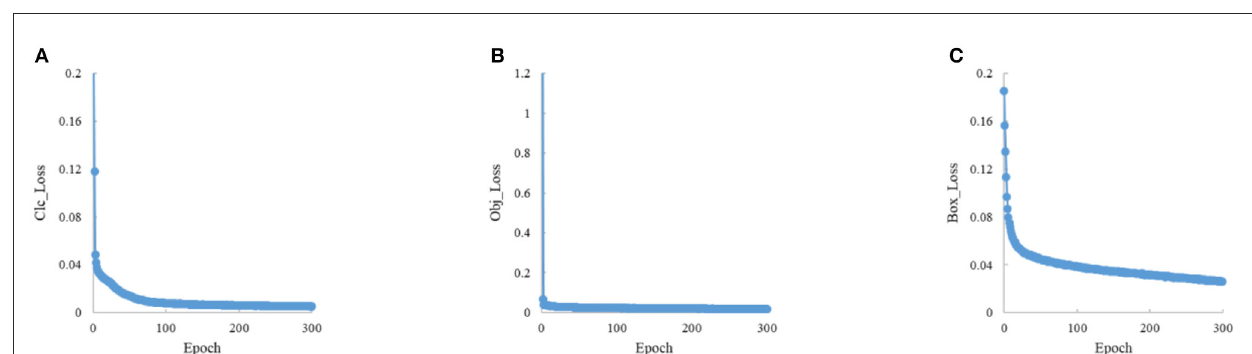
FIGURE7 The training loss convergence curve. (A) The loss of class. (B) The loss of object. (C) The loss of